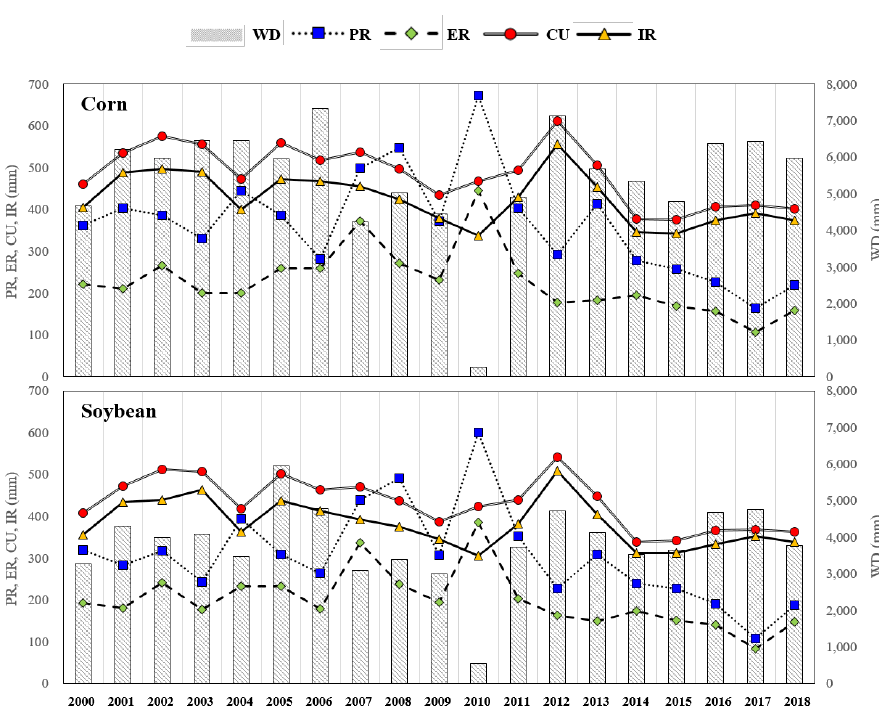
Figure 3. Results of annual water balance results (precipitation, consumptive use, effective rainfall, irrigation requirement, and water deficit) for corn and soybean in Illinois, USA.